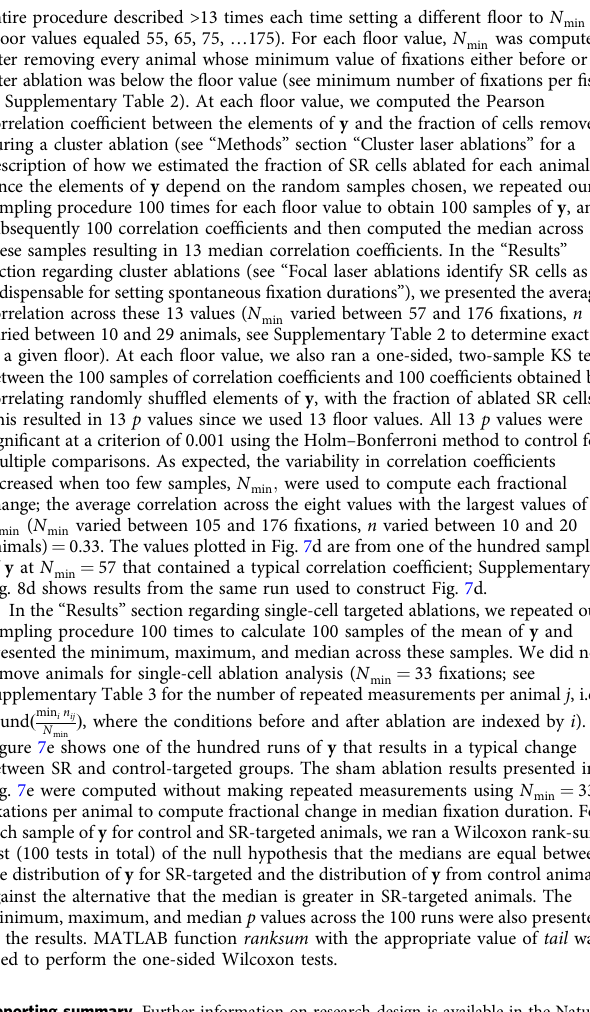
used to perform the one-sided Wilcoxon